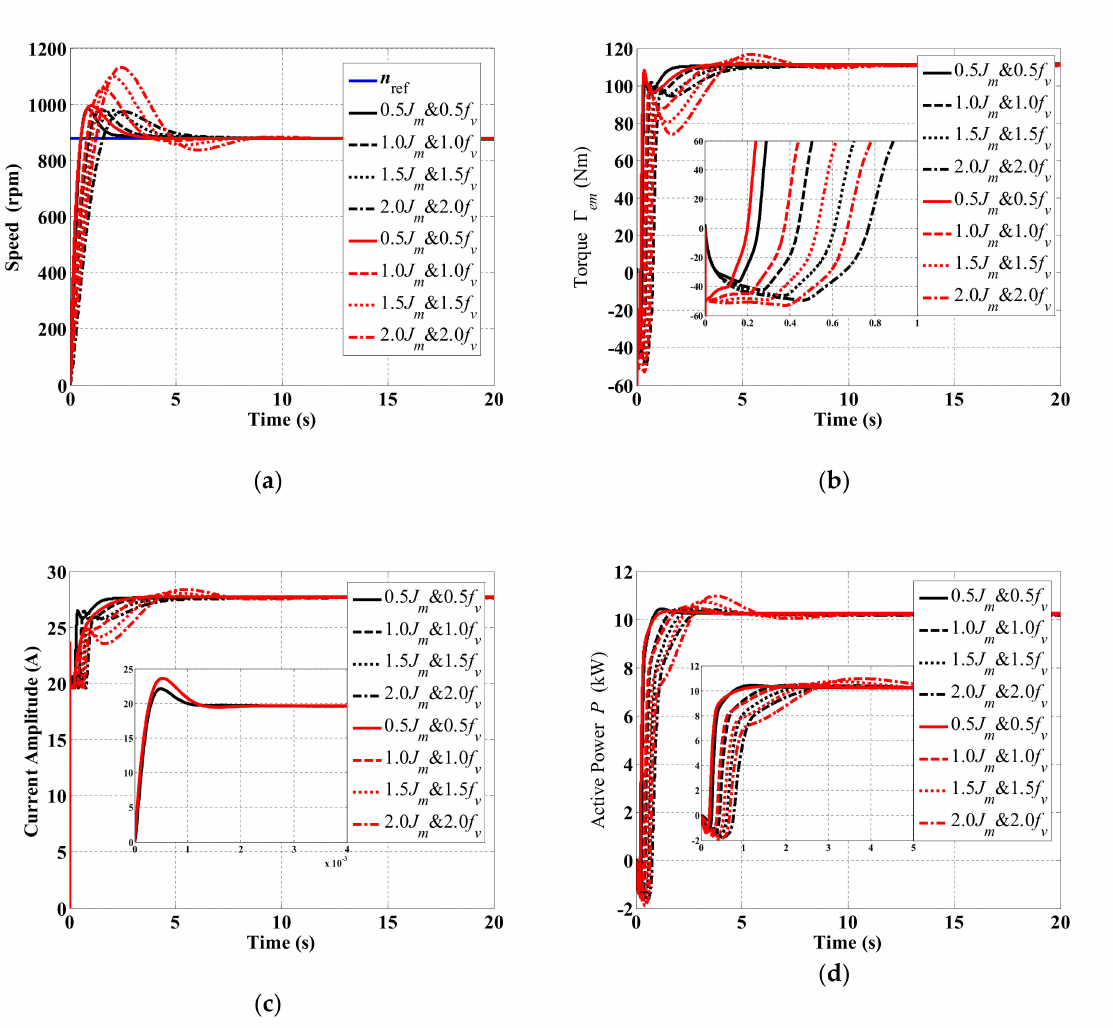
Figure8. PerformanceofDFIGforFOPI(black)andIOPI(red)controllerswiththeinaccuratemechanical model: ( a ) DFIG speed; ( b ) electromagnetic torque; ( c ) rotor current amplitude; ( d ) active